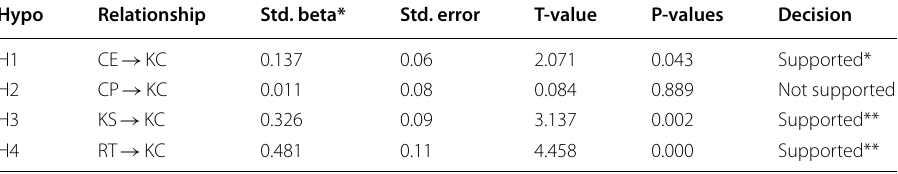
Significant at P**